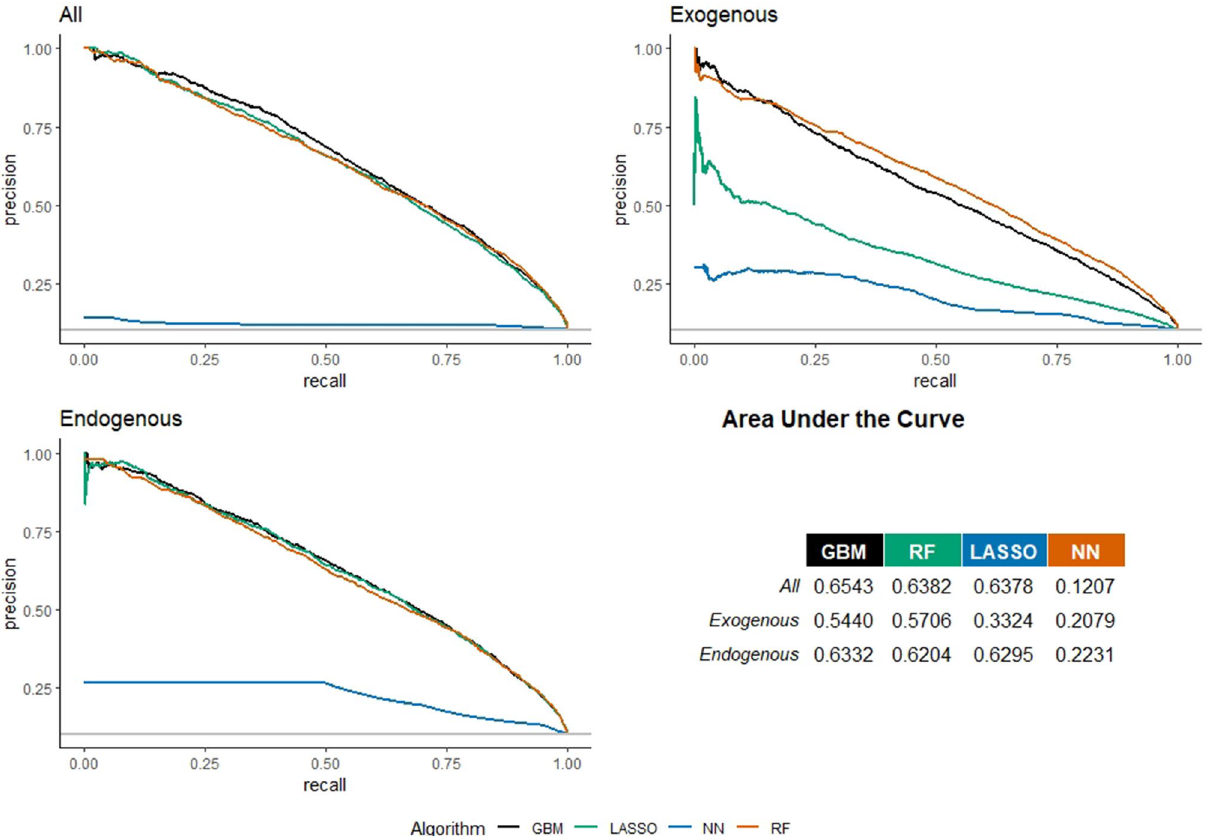
Figure 1. Precision–recall curves for European universities’ co-publication prediction in the Social Sciences and Humanities domain. Three models considered: with all, with only exogenous, and with only endogenous